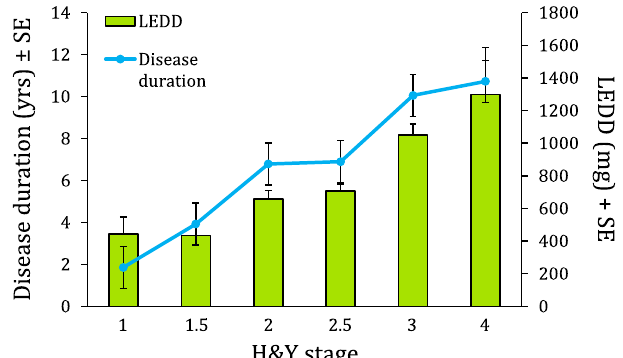
Figure 1. Disease duration (left ordinate) and levodopa equivalent daily dosage (LEDD) (right ordinate) over the different stages of the H&Y scale (abscissa). The green bars and the blue line show the parallel trend of disease duration and LEDD. The H&Y staging faithfully reflected the progression of the disease and the amount of medication